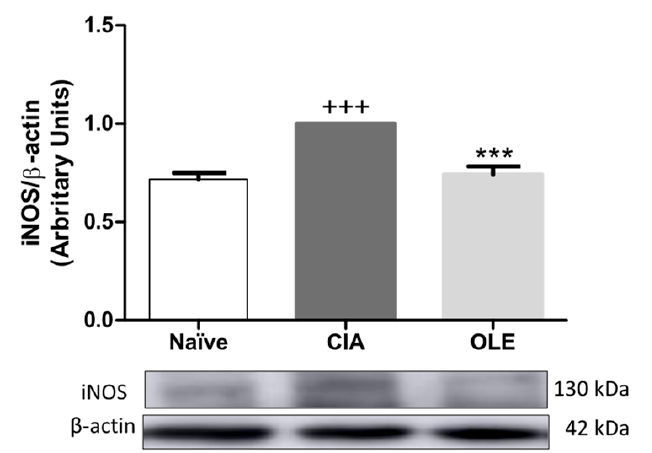
observed in hind paw of CIA mice group submitted to treatment with OLE-supplemented diet when compared with CIA mice received SD diet ( p < 0.001 vs. CIA), as shown in Figure 6.